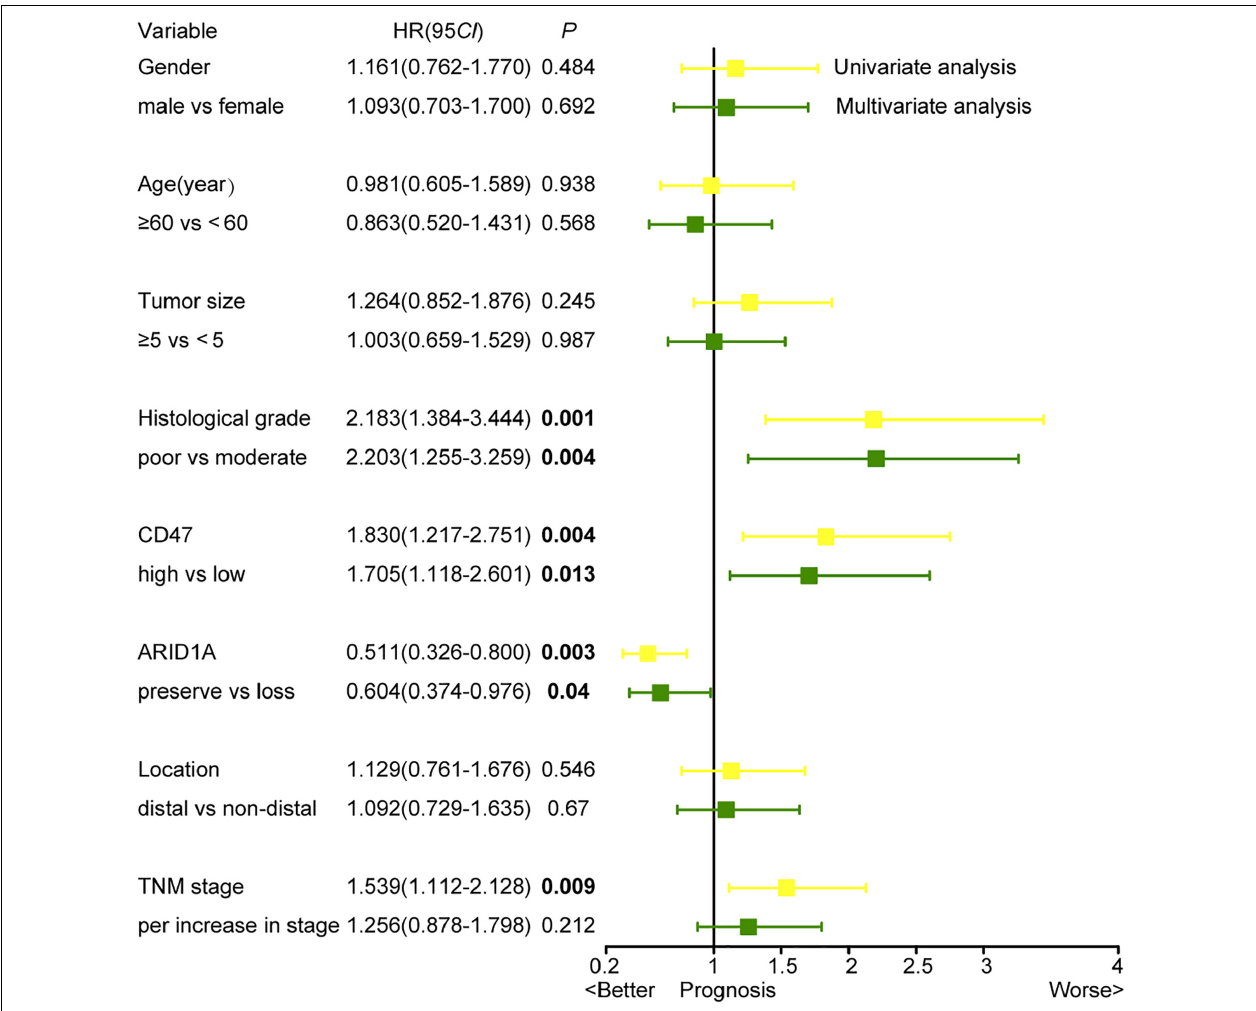
FIGURE 4 | Univariate and multivariate analyses based on clinicopathological